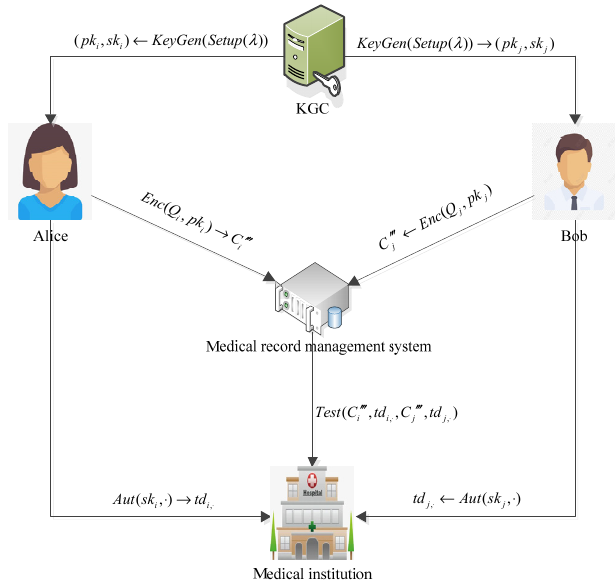
Figure 5. The process of equality testing.